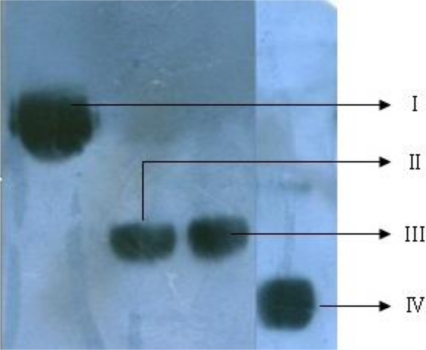
Western Blot analysis of PEGylated HM-3. (I) SC-mPEG20k-HM-3; (II) SC-mPEG10k-HM-3; (III) ALD-mPEG10k-HM-3; (IV) ALD-mPEG5k-HM-3.